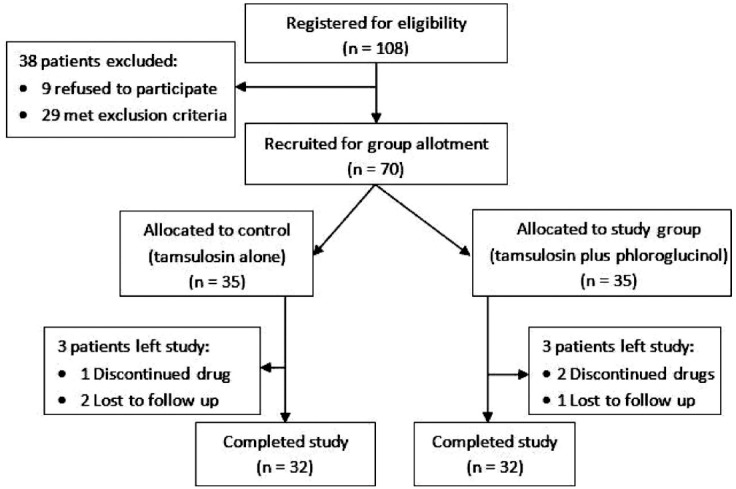
Flow diagram of subject sampling.